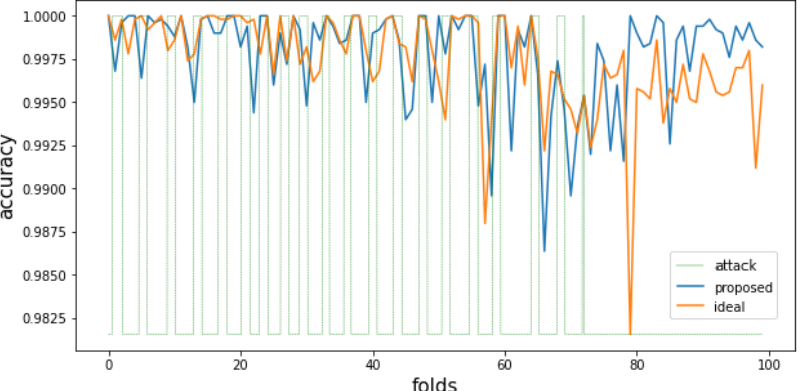
Figure 9. Attack classification accuracy of the proposed and ideal methods when the size of the pure dataset is 40,000 and the proportion of attack data is